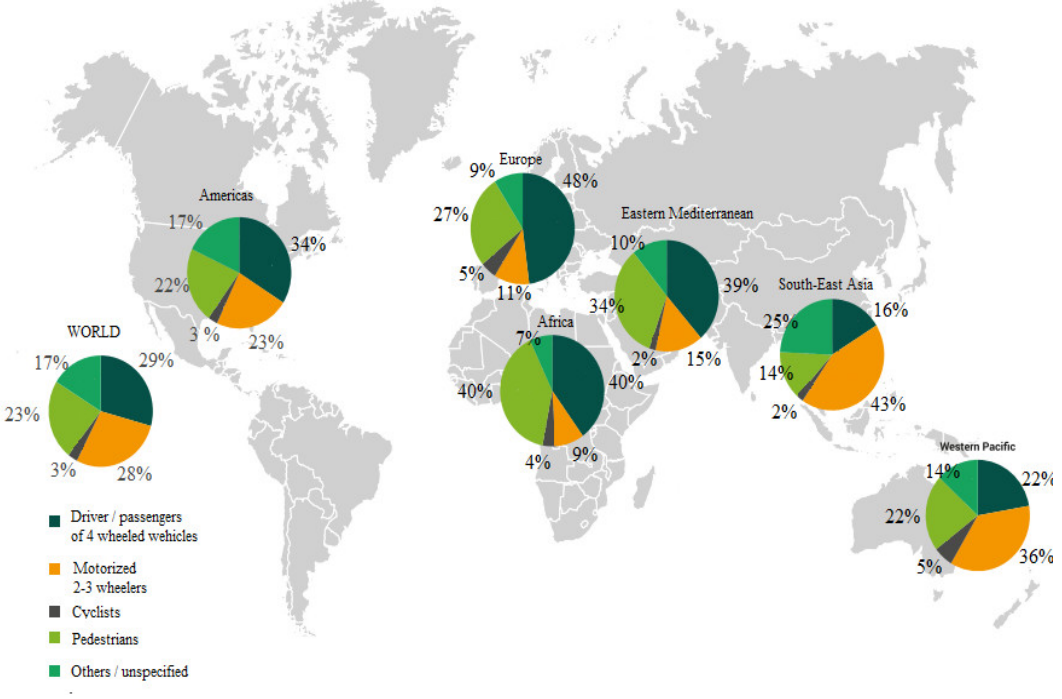
Figure 1. Distribution of fatalities in road accidents according to WHO by road user type [3].